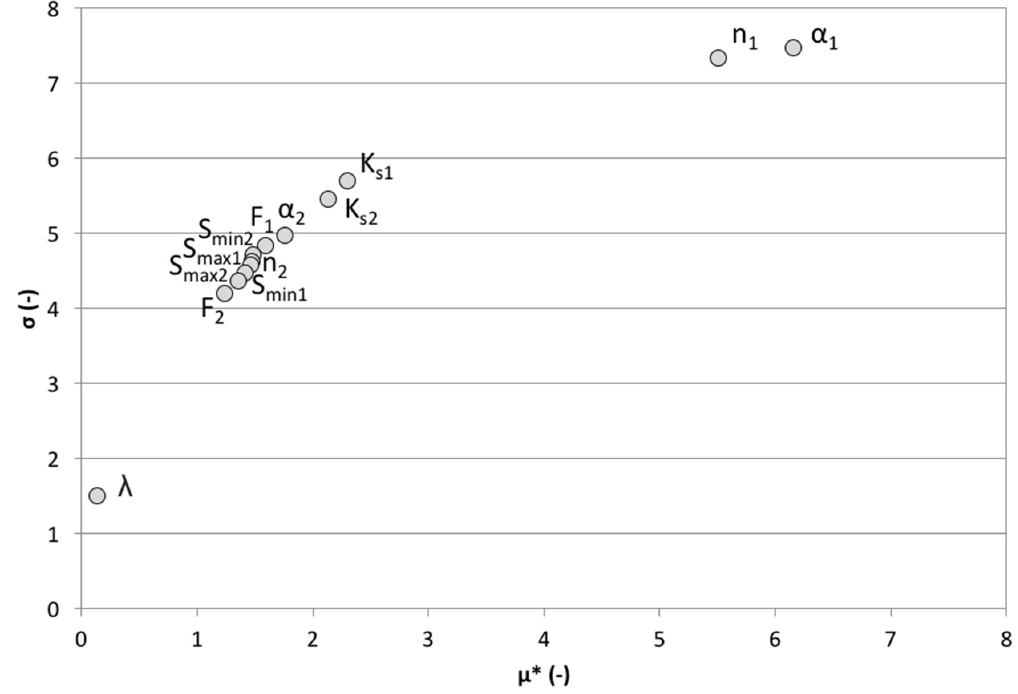
Figure 1. Results of the Morris method sensitivity analysis for output groundwater